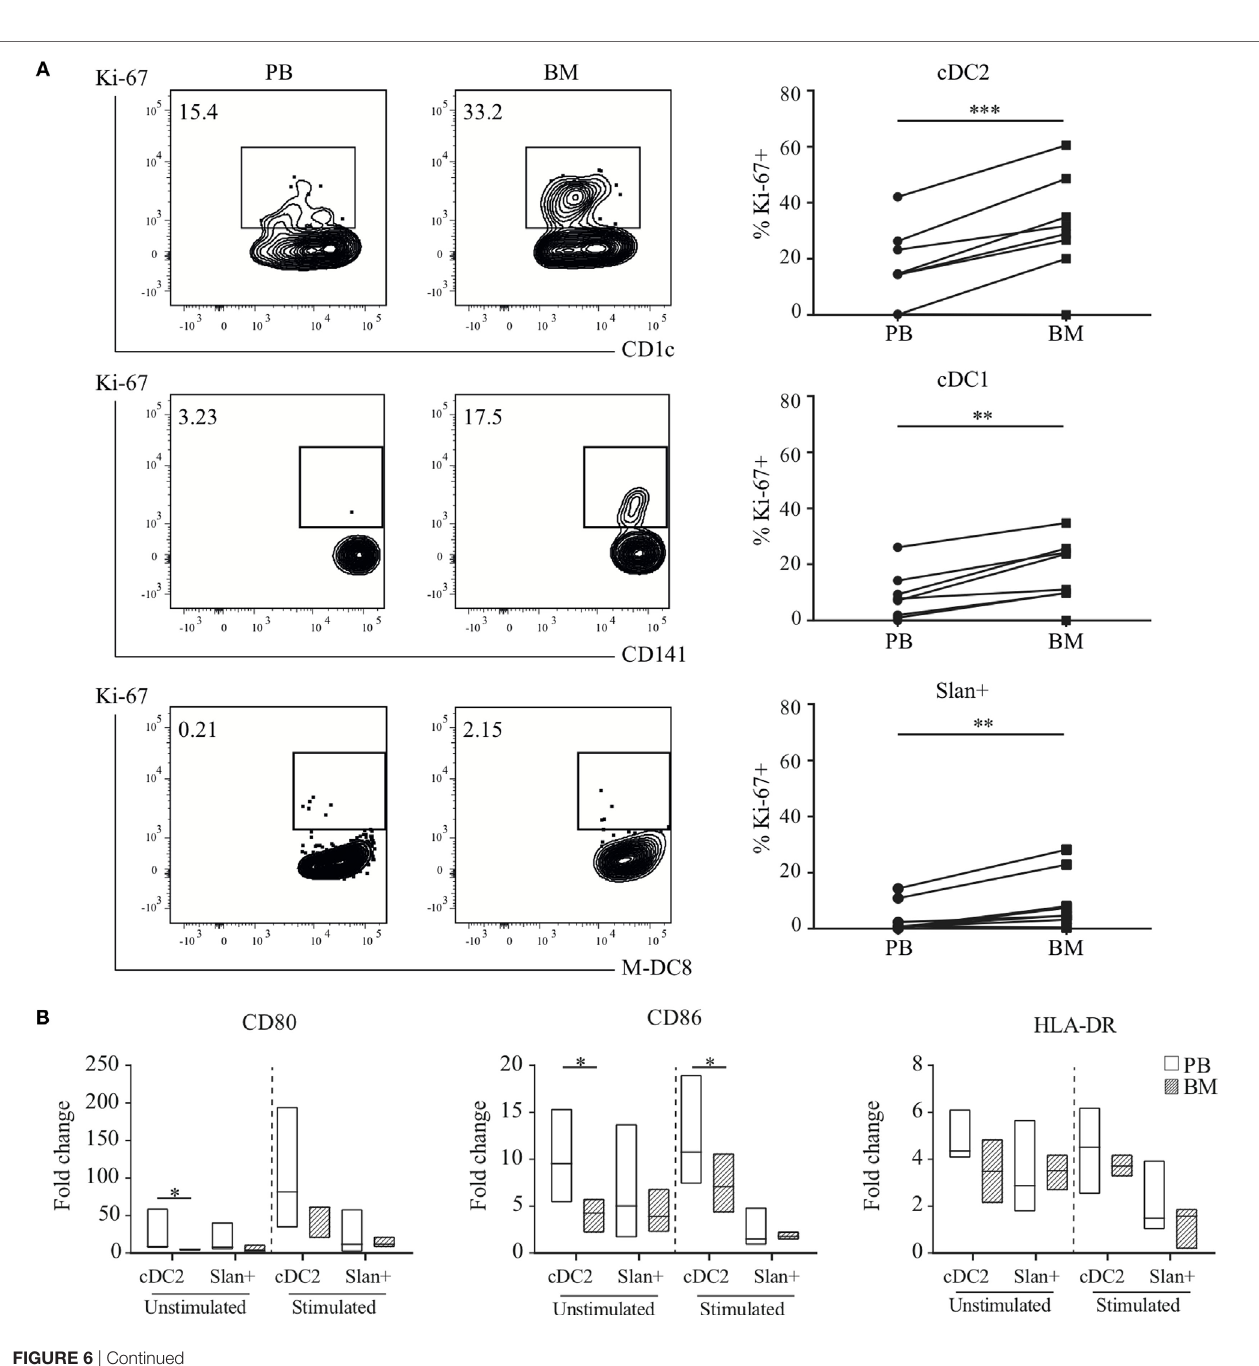
FigUre 5 | Compartment-specific DC gene signatures for cDC2 and cDC1. Both myeloid DC subsets were further analyzed to find compartment-specific DC gene signatures. (a) Transcripts were filtered based on gene descriptions and GO biological process terms by using cell cycle- and immune response-related terms. Relative expression for cDC2 and cDC1 in both bone marrow (BM) as well as peripheral blood (PB) are shown for selected genes. Venn diagrams were used to obtain overlapping genes between cDC2 and cDC1 in the BM (B) and PB (c) compartment. (D) The 581 commonly over-expressed transcripts in BM-derived DCs were used in a pathway enrichment analysis. (e) Similarly, overlapping transcripts (131 in total) of PB cDC2 and cDC21 were used in the STRING pathway analysis. (F) An interaction network of the PB transcripts was generated. In total, 85 genes could be annotated. The minimum required interaction score was set to medium confidence (0.400), disconnected nodes were hidden and the thickness of the lines indicates the strength of data support. Abbreviations: FDR, false discovery rate; GO, gene ontology; ID,